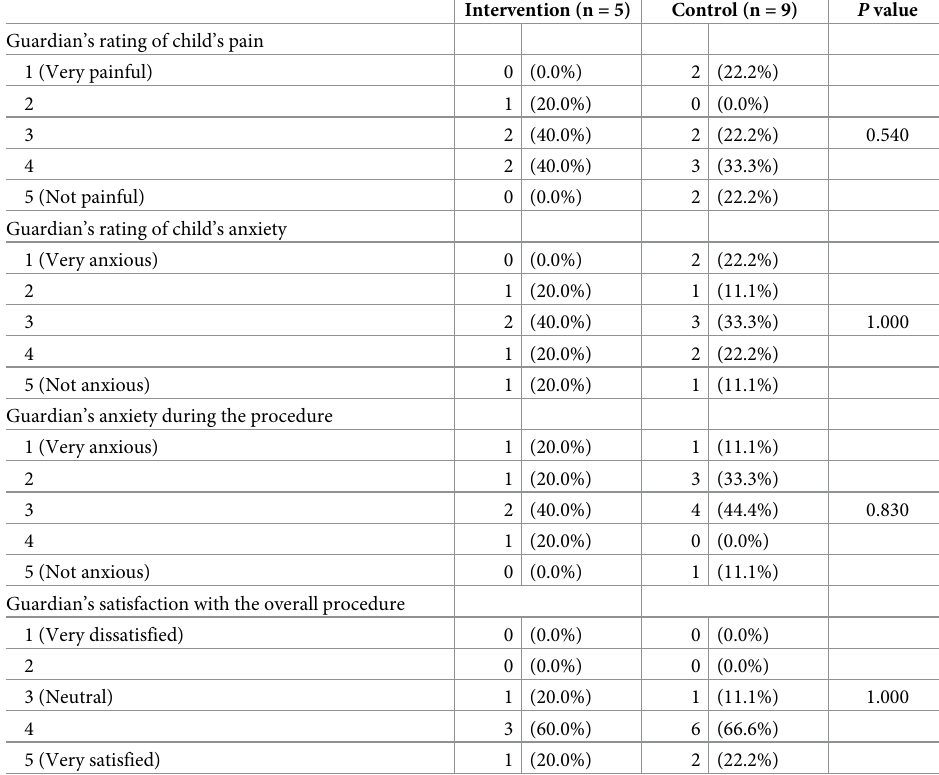
Table 3. Guardian’s response to postprocedural